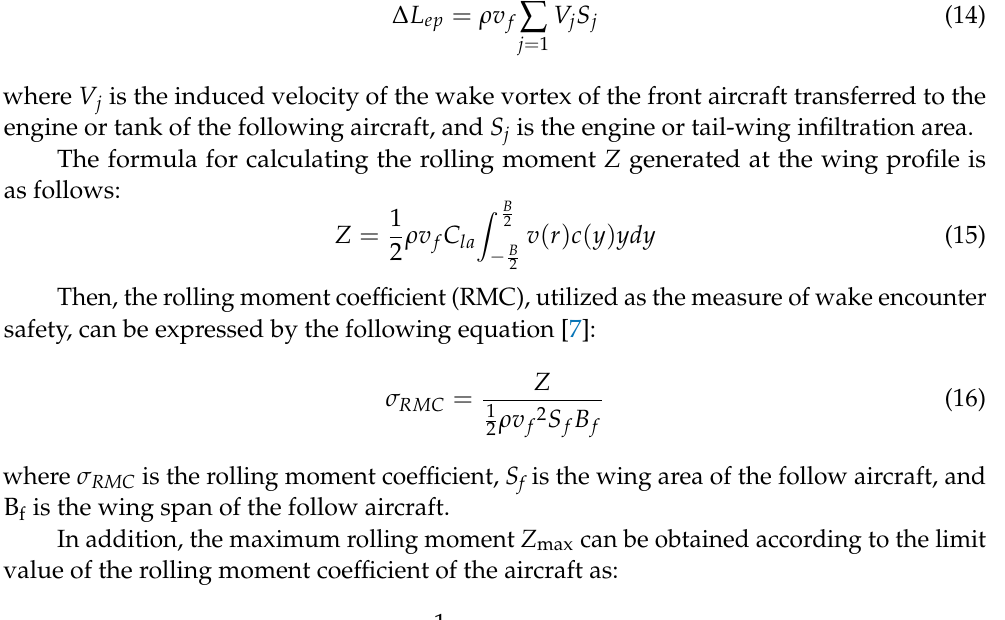
Figure 2. Force model of CRJ-900 and coordinate axis.